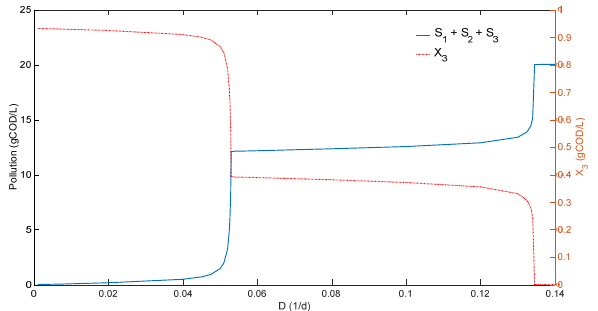
Figure 2. Effect of the dilution on the organic pollution level and methanogenic biomass concentrations.